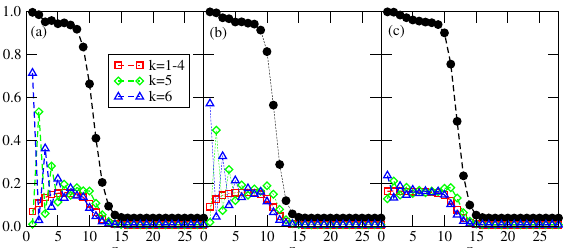
Figure 16. The local density profiles recorded for u ∗ = − 0.2, at T = 0.33 and µ = − 1.2725, for three different values of V o = − 1.0 ( a ), − 4.0 ( b ) and − 8.0 ( c ). The filled circles correspond to ρ ( z ) , while the open symbols correspond to ρ k ( z )